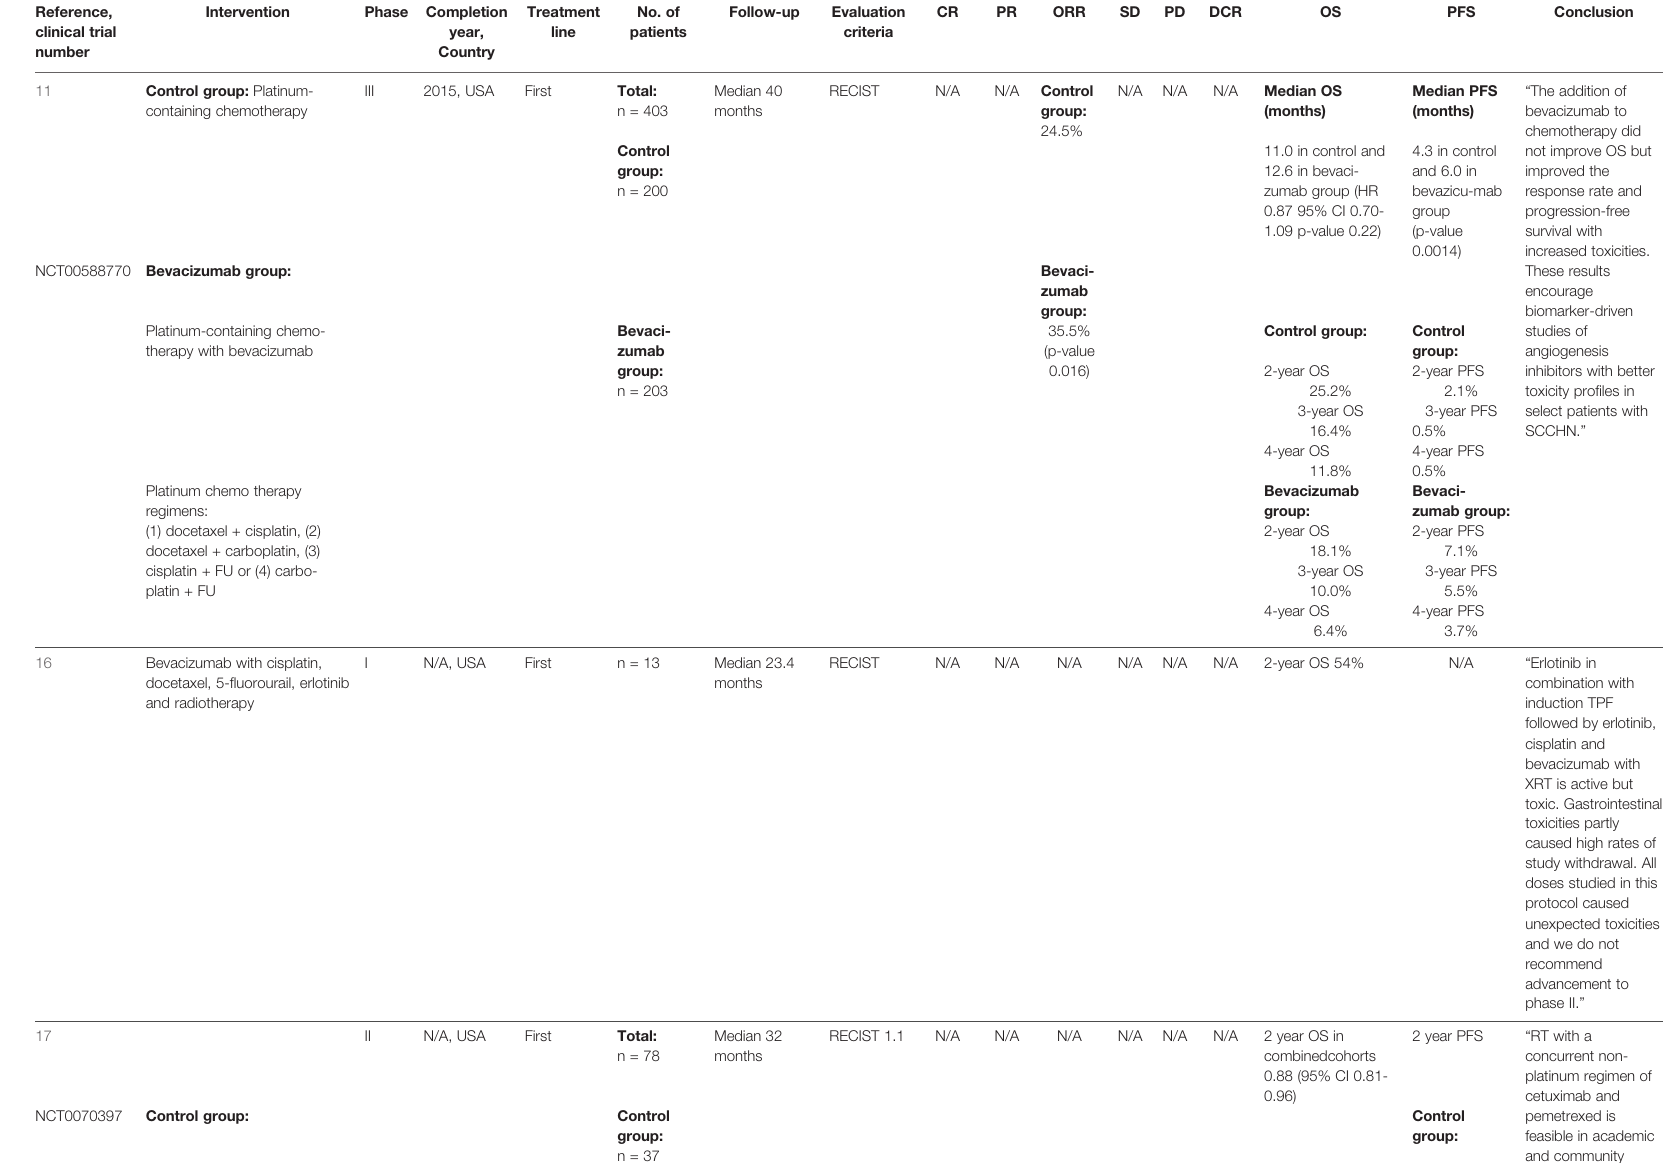
TABLE 1 | Summary of the bevacizumab clinical trials for head and neck squamous cell carcinoma. Reference, clinical